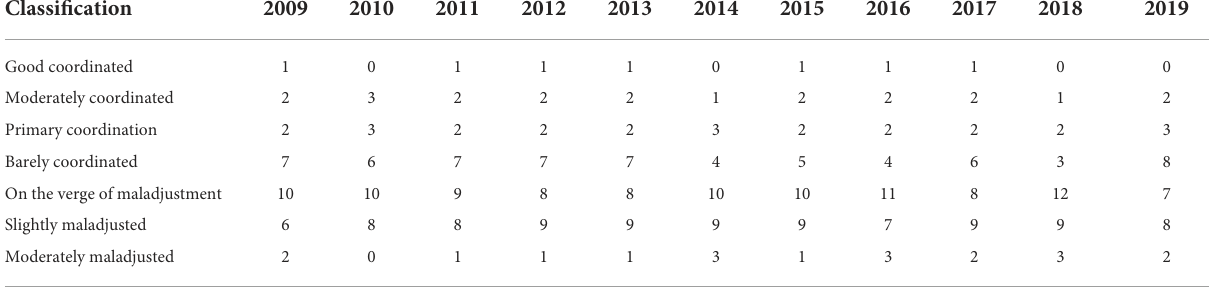
TABLE 5 Number of provinces and cities with different coupling coordination levels in China, 2009–2019 (unit). Classification